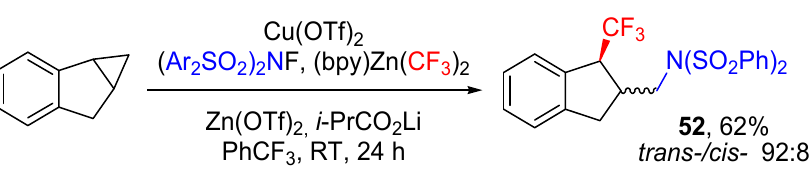
ing to 1-CF 3 -indane 52 . to 1-CF 3 -indane 52 .